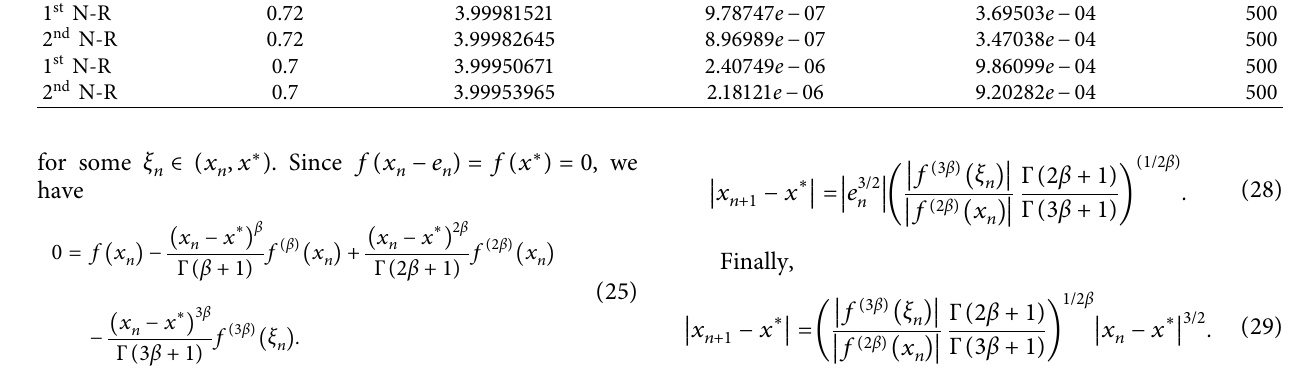
Table 1: First-order FNR and second-order FNR results for f β x n +